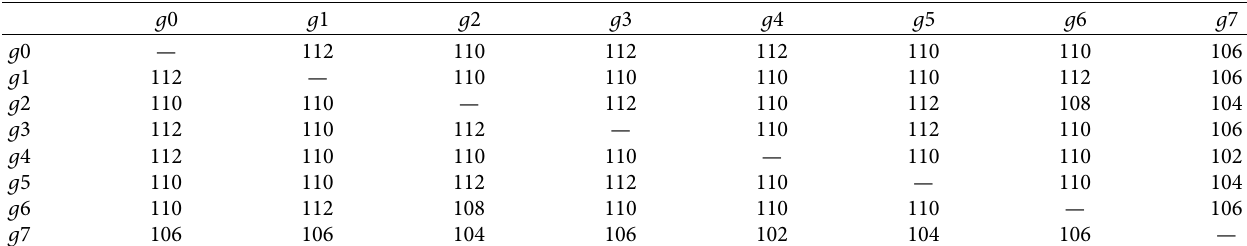
Table 5: Nonlinearity scores of pairwise independent Boolean functions for BIC analysis of proposed